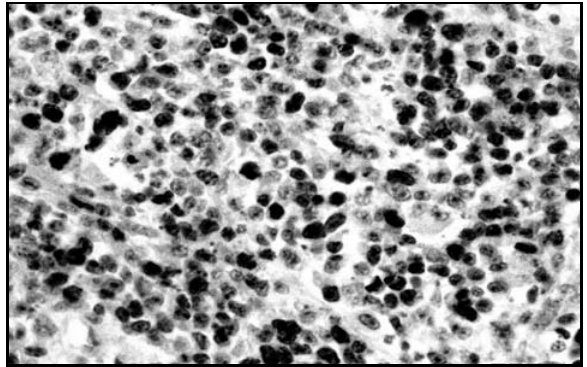
Figura 4 – Em detalhe (40X), marcação das células tumorais maiores que 5%